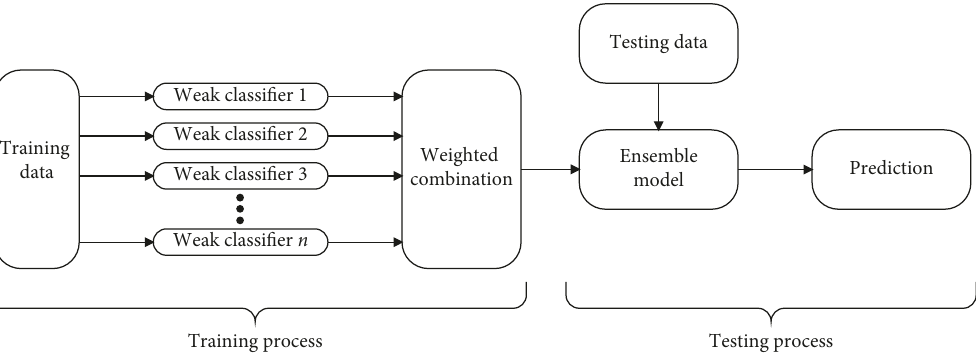
Figure 13: AdaBoost classifier flow chart.